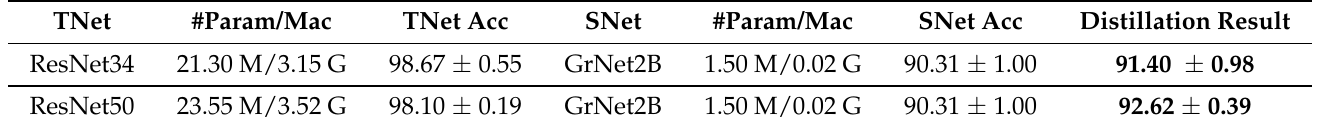
Table 3. The accuracy of ResNet34 and ResNet50 on UC Merced Land Use datasets.